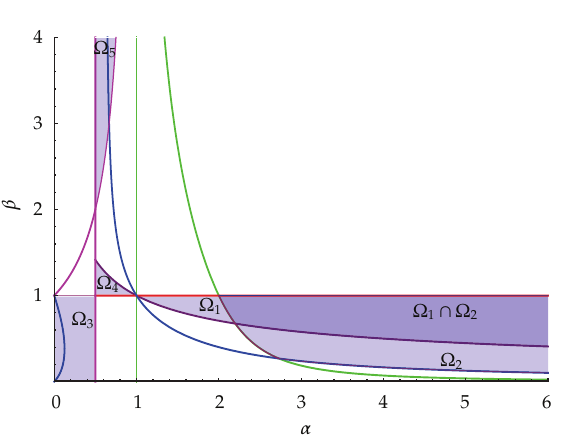
Figure 2: The shading areas are respectively denoted by the subsets Ω i for i (cid:4) 1 , 2 ,..., 5. The function f α,β (cid:2) x (cid:3) is strictly logarithmically completely monotonic on (cid:2) 0 , ∞ (cid:3) if (cid:2) α,β (cid:3) ∈ Ω 3 ∪ Ω 4 ∪ Ω 5